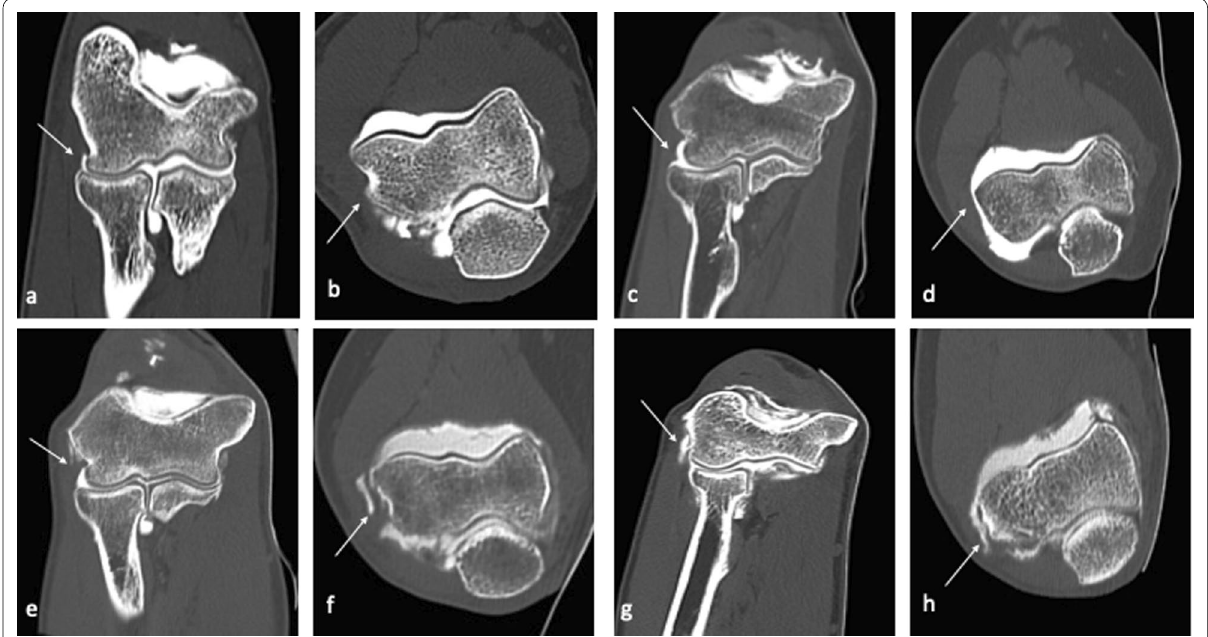
Fig. 11 CT-arthrography coronal ( a , c , e , g ) and axial ( b , d , f , h ) images belonging to four patients, three of which display different aspects of symptomatic minor instability of the lateral elbow (SMILE), involving the RCL (white arrows). Intact radial band (RCL) of the lateral collateral ligament (LCL) complex ( a , b ). Widening of the lateral aspect of the articular recess associated to a curve-shaped, loose RCL with no evidence of fiber tearing, suggestive of patholaxity ( c , d ). Thickened and irregular RCL showing partial-thickness tear ( e , f ) and full-thickness tear ( g , h ); iodinated contrast progressively leaks through the ligament, as fibers are gradually disrupted and damage progresses from a partial to a full-thickness